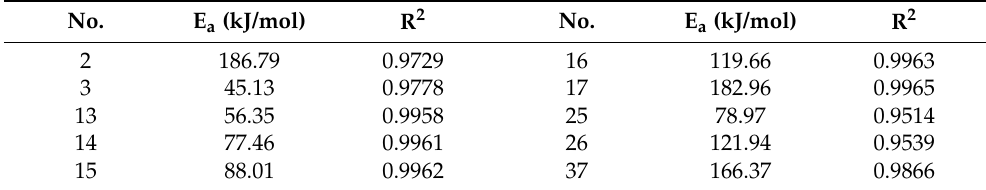
Table 10. Calculated results of TBPTMH with NaOH at different G ( α ) by Coats–Redfern method.